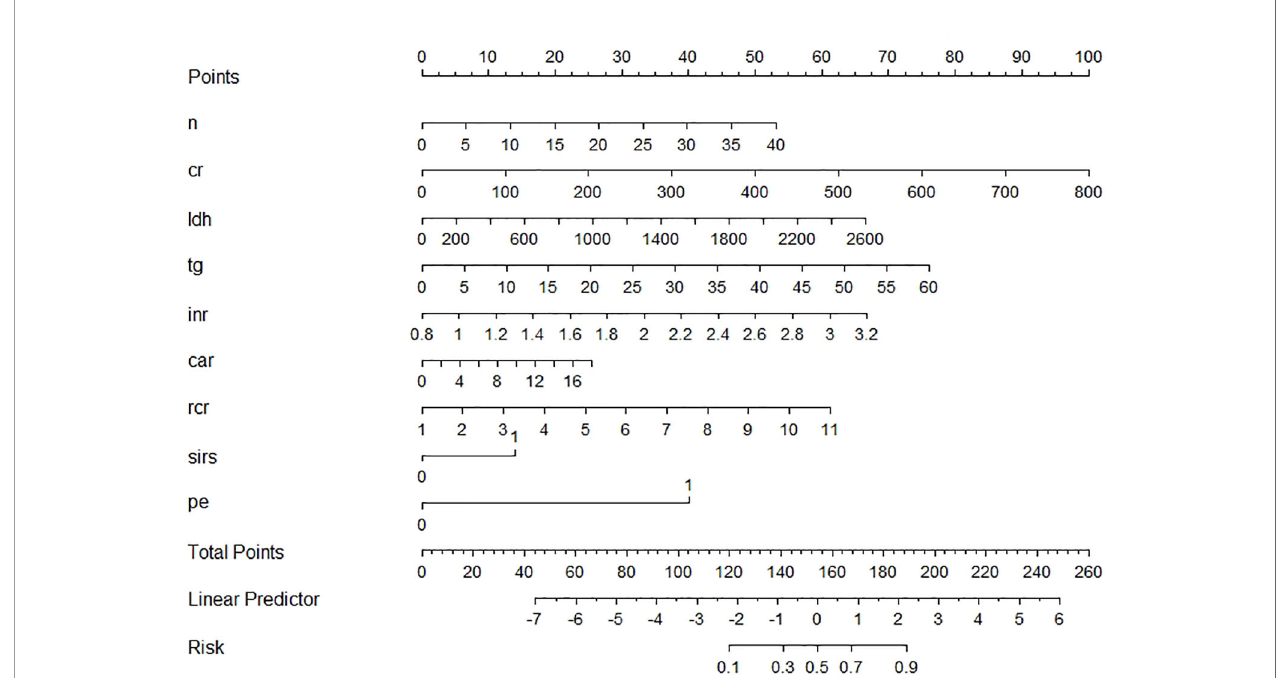
FIGURE 2 | Nomogram of the LASSO model for the early prediction of severe acute pancreatitis.